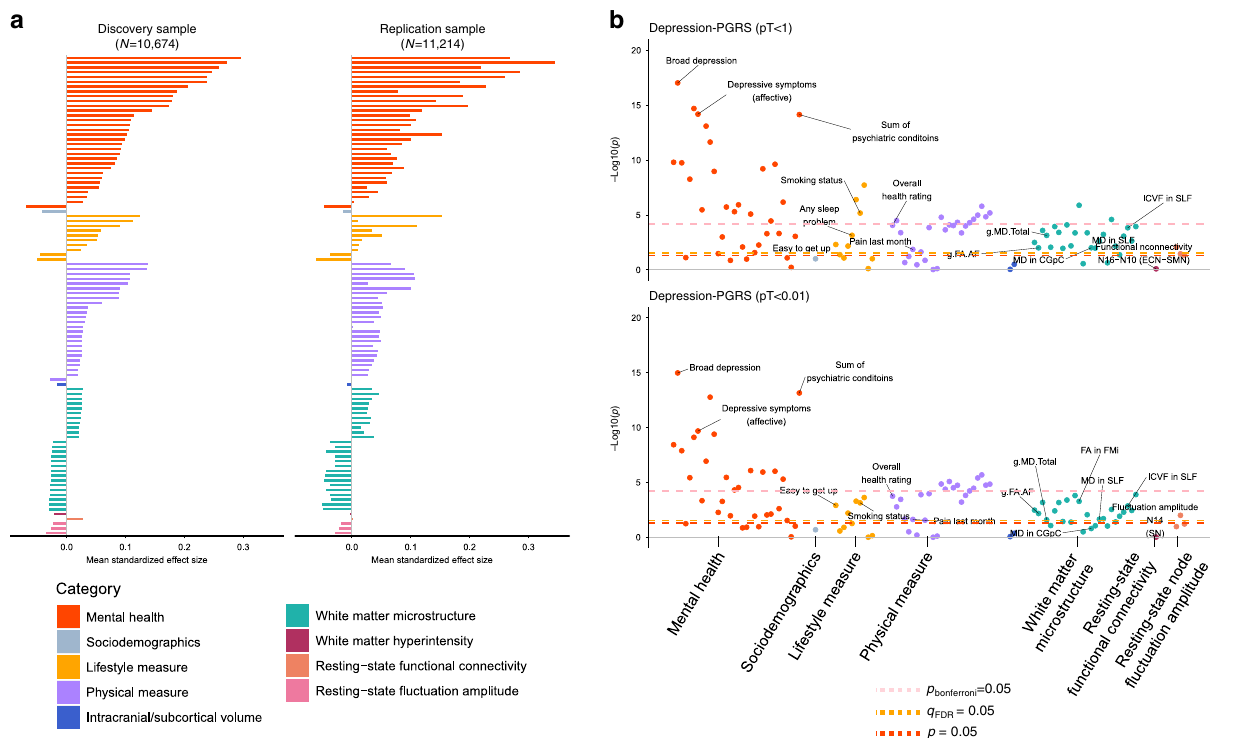
Fig. 3 Results for replication analysis. a Comparisons of effect sizes for the discovery and replication samples. The x axes represent the mean standard effect size across depression-PRS at all eight p thresholds for generating depression-PRS (pT). Colours for the bars indicate their categories (from top to bottom: mental health measure, sociodemographics, lifestyle measure, physical measure, intracranial/subcortical volume, white matter microstructure, white matter hyperintensity, resting-state functional connectivity, and resting-state fl uctuation amplitude). b Signi fi cance plot for the replication analysis on representative depression-PRS at pT < 1 and pT < 0.01, in accordance with Fig. 1. The x axes represent phenotypes, and the y axes represent the − log 10 of uncorrected p values of two-sided test for linear regression between depression-PRS and each of the phenotype. Each dot represents one phenotype, and the colours indicate their according categories. The yellow dashed lines indicate the threshold to survive FDR-correction. FDR-correction was applied over all the traits and all depression-PRS (see “ Methods ” ). The pink and red dashed lines indicate the threshold to survive Bonferroni correction and nominally signi fi cant threshold. Top hits shown in the discovery sample (Fig. 1) are annotated in the fi gure. Explanations for the abbreviations can be found in the legend of Fig.